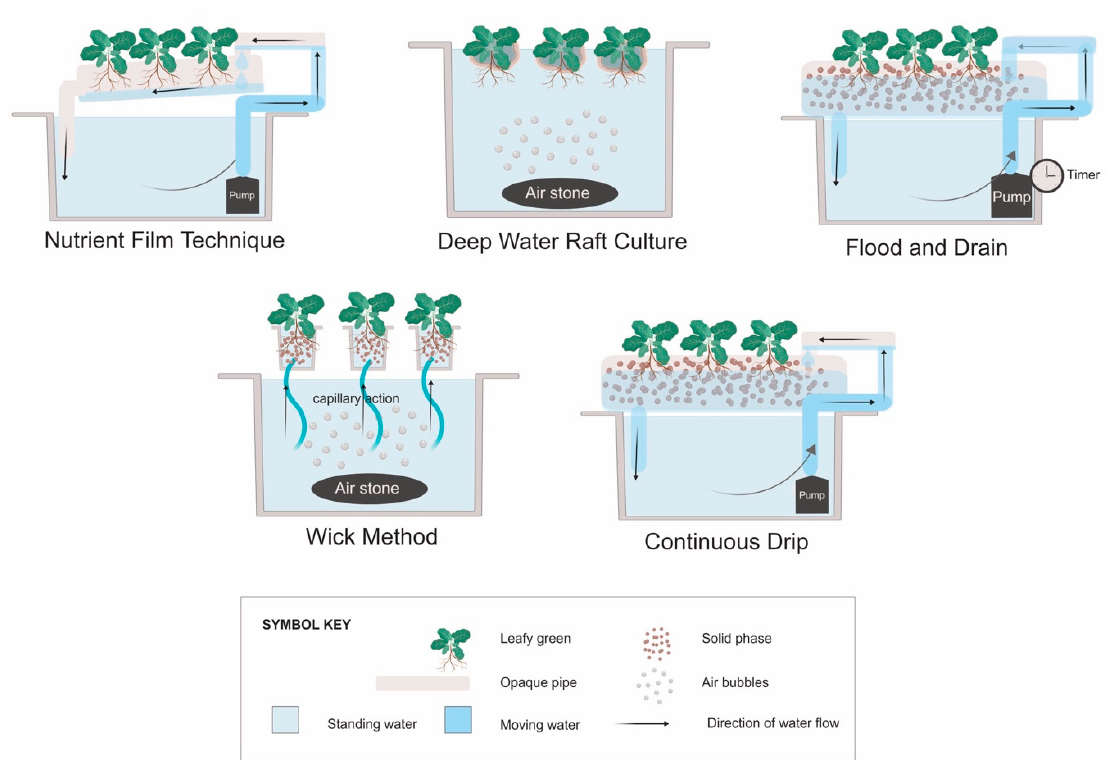
Figure 1. Types of hydroponic plant culture systems. “Deep water raft culture” may also be referred to as “float hydroponics” [36], while “flood and drain” can be referred to as “ebb and flow” [39]. The “continuous drip” system is typically called a “drip system” [36], but “continuous” is used here to differentiate it from flood and drain systems that have similar construction, but the pump runs intermittently.